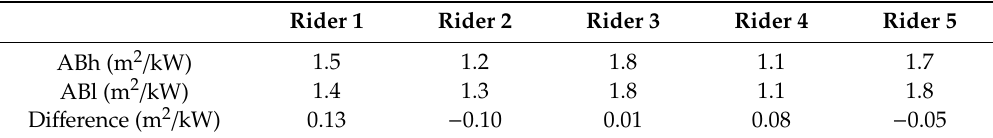
Table 6. Relationship between drag area and power delivery capacity.